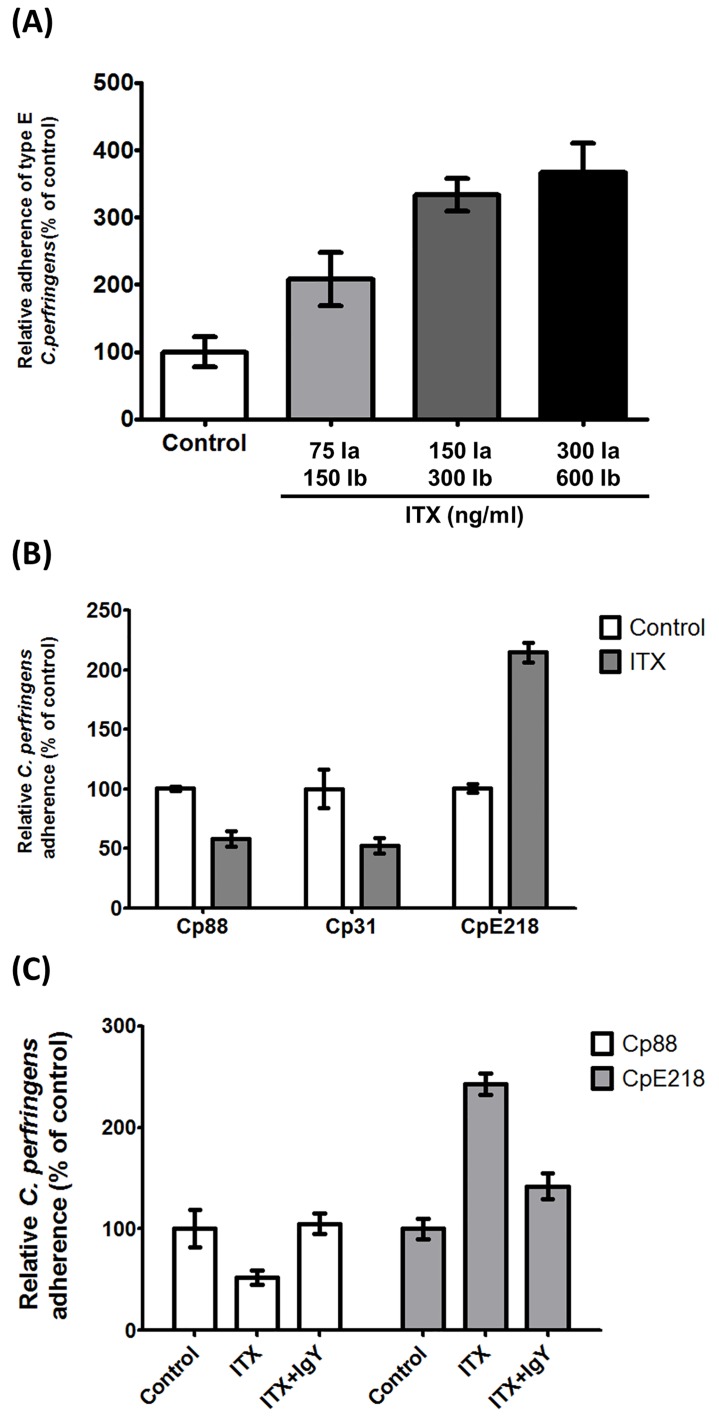
Iota toxin increases type E adherence while decreases type A adherence.
(A) ITX treatment increases the adherence of C. perfringens type E (CpE218). Cells were incubated with the indicated toxin concentrations. 75ng/ml Ia +150ng/ml Ib, 150ng/ml Ia +300ng/ml Ib and 300ng/ml Ia +600ng/ml Ib. After ITX treatment, cells monolayers were incubated with type E bacteria. Cells were lysed and total clostridia were plated onto neomycin blood agar plates for counting. (B) ITX treatment increases the adherence of type E bacteria (CpE218), and reduce adherence of type A bacteria (Cp88—Cp31). Cells were treated with 150 ng/ml Ia and 300 ng/ml Ib (ITX), and washed 3 times with PBS. After ITX treatment, cells monolayers were incubated with the indicated strains. (C) ITX induced changes in bacterial adherence were neutralized by addition of anti-ITX IgY. Cells were treated with 150 ng/ml Ia and 300 ng/ml Ib (ITX) with or without neutralizing IgY. After treatment, cells monolayers were incubated with the indicated strains. Attachment levels were quantified as percent of bacterial adherence relative to untreated cells. Results shown represent the average of three independent experiments; error bars indicate the standard error of the mean (SEM).